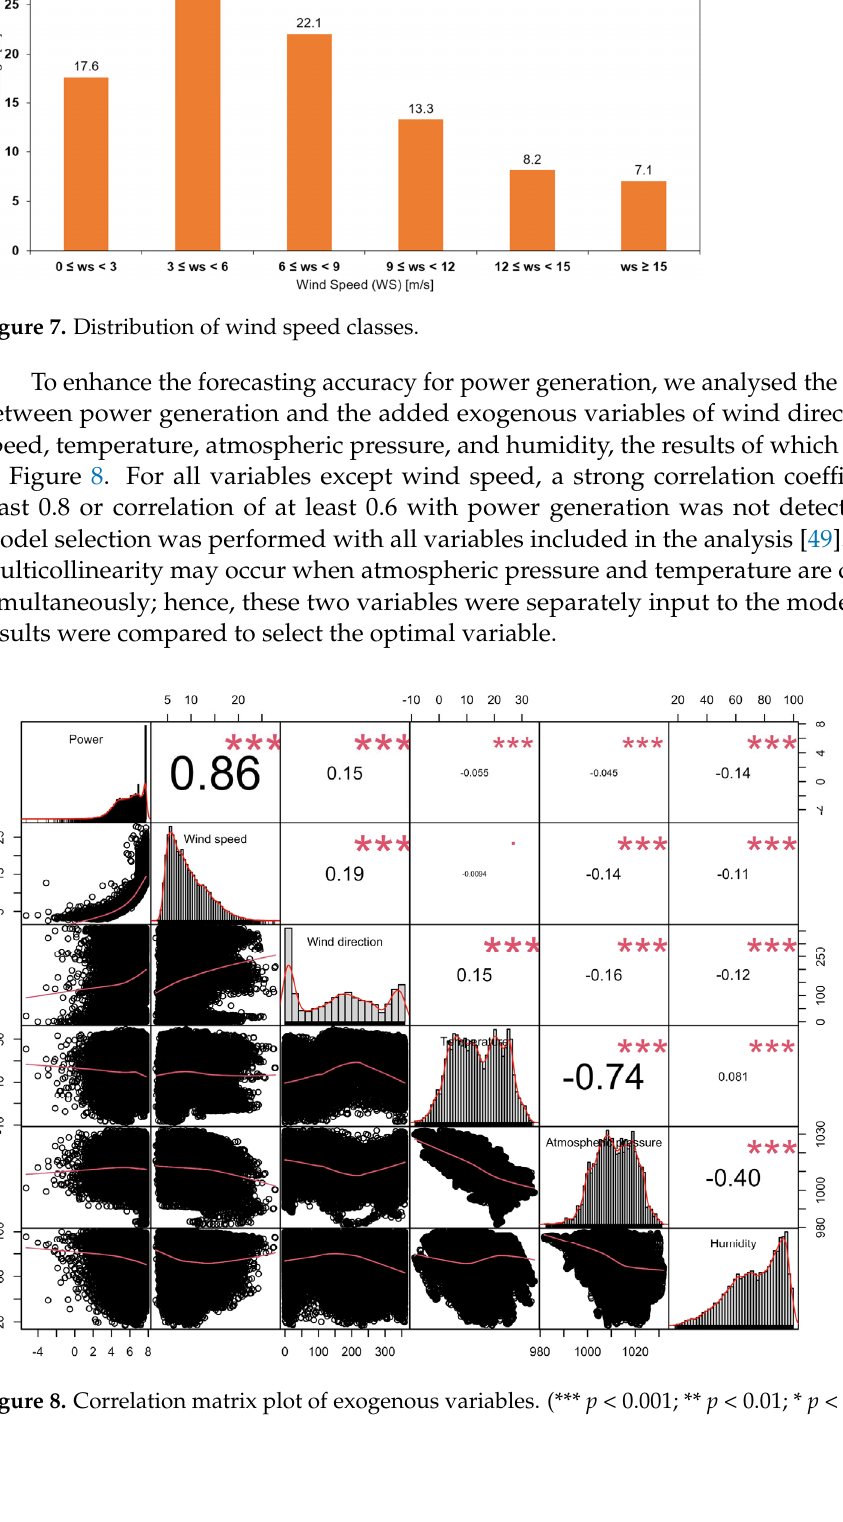
Figure 6. Distribution of wind direction.